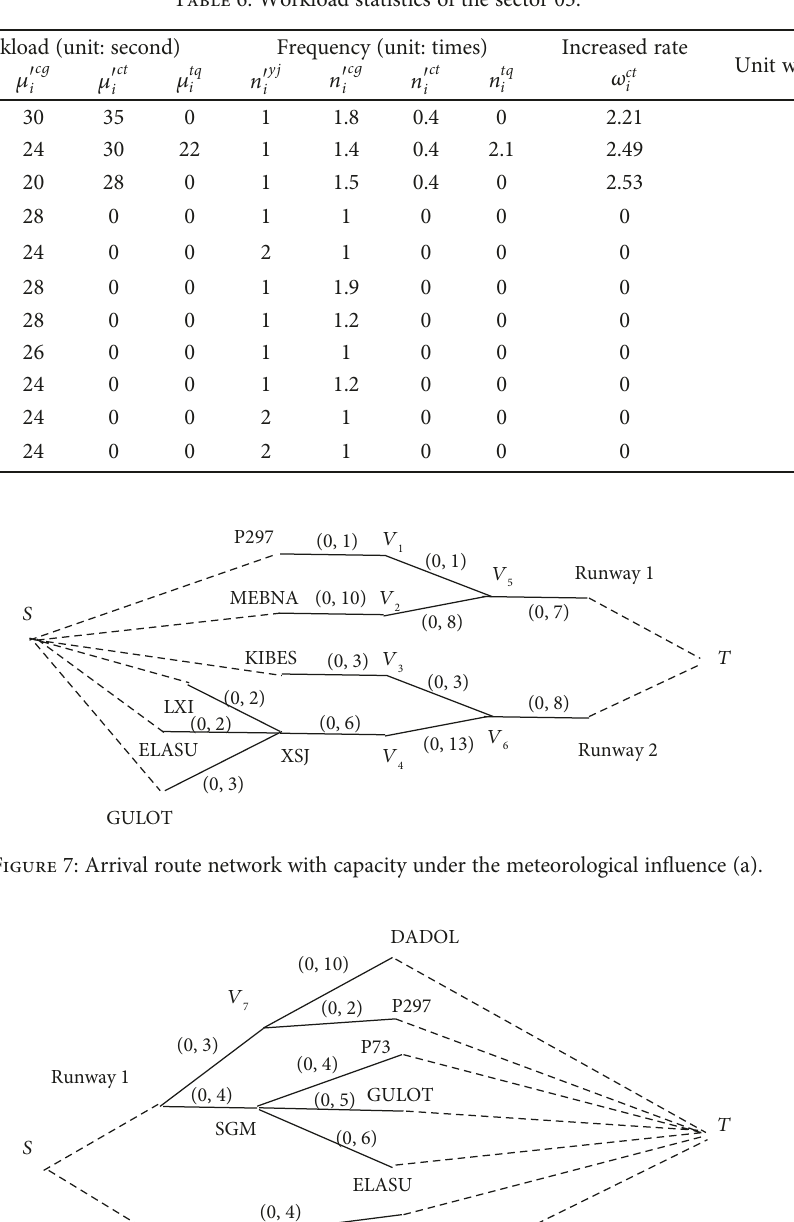
Table 6: Workload statistics of the sector 03.